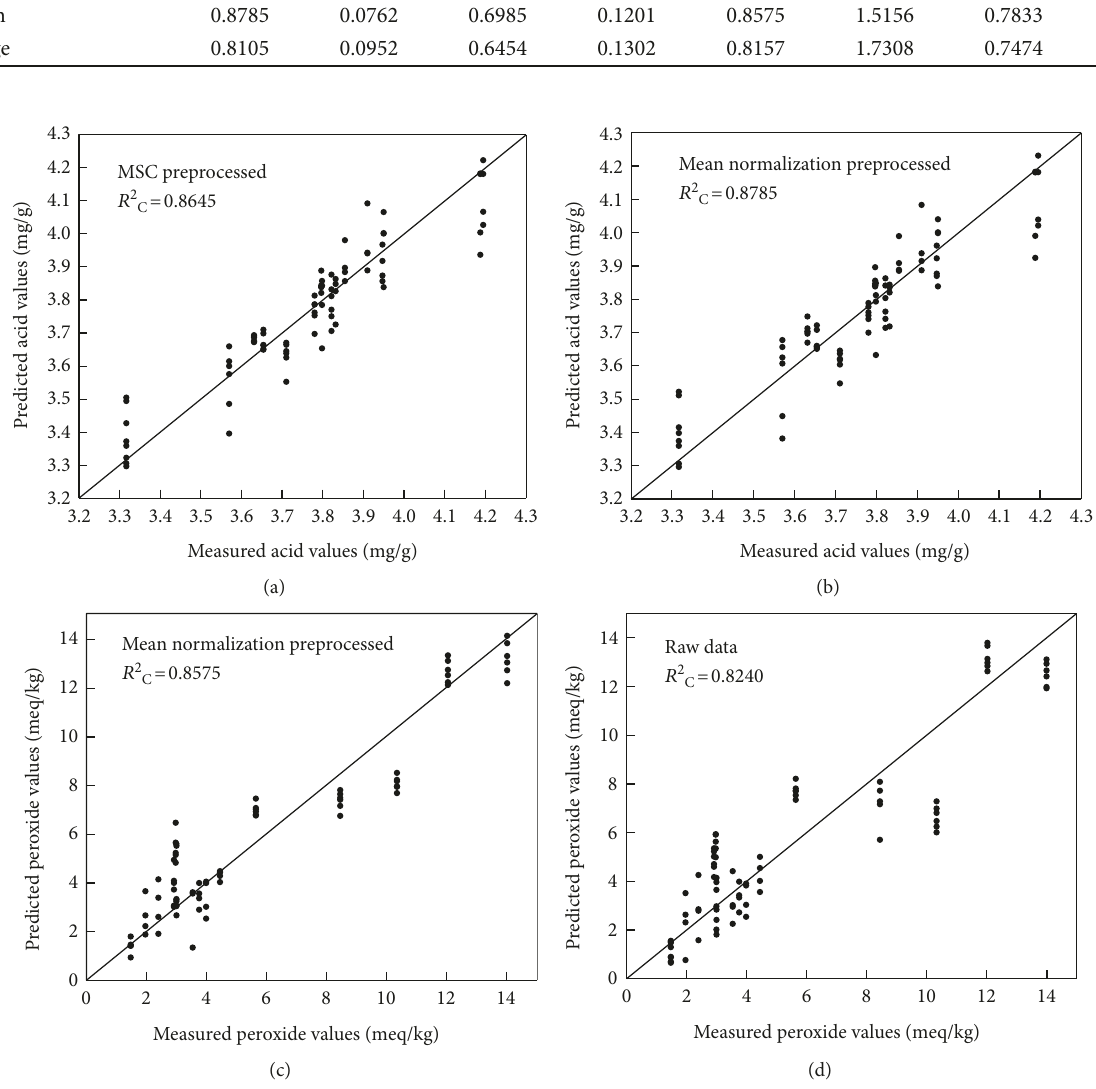
Figure 5: Prediction results of PCR models for acid and peroxide values from the highest R 2 values. (a) Acid value with MSC preprocessed. (b) Acid value with mean normalization. (c) Peroxide value with mean normalization. (d) Peroxide value with raw